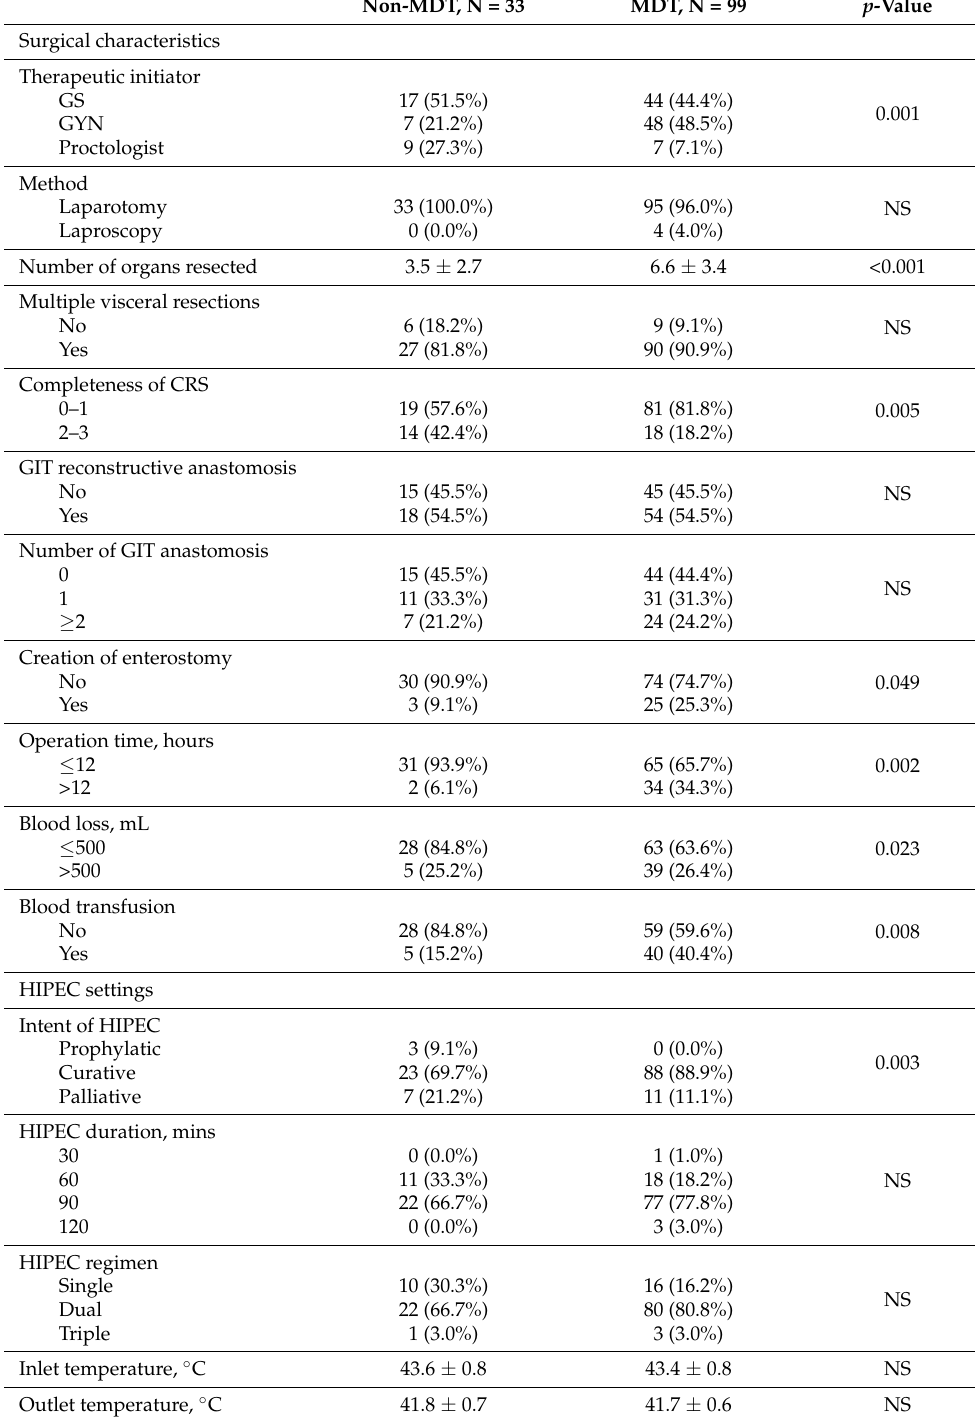
Table 2. Surgical settings and procedures of the patients who underwent